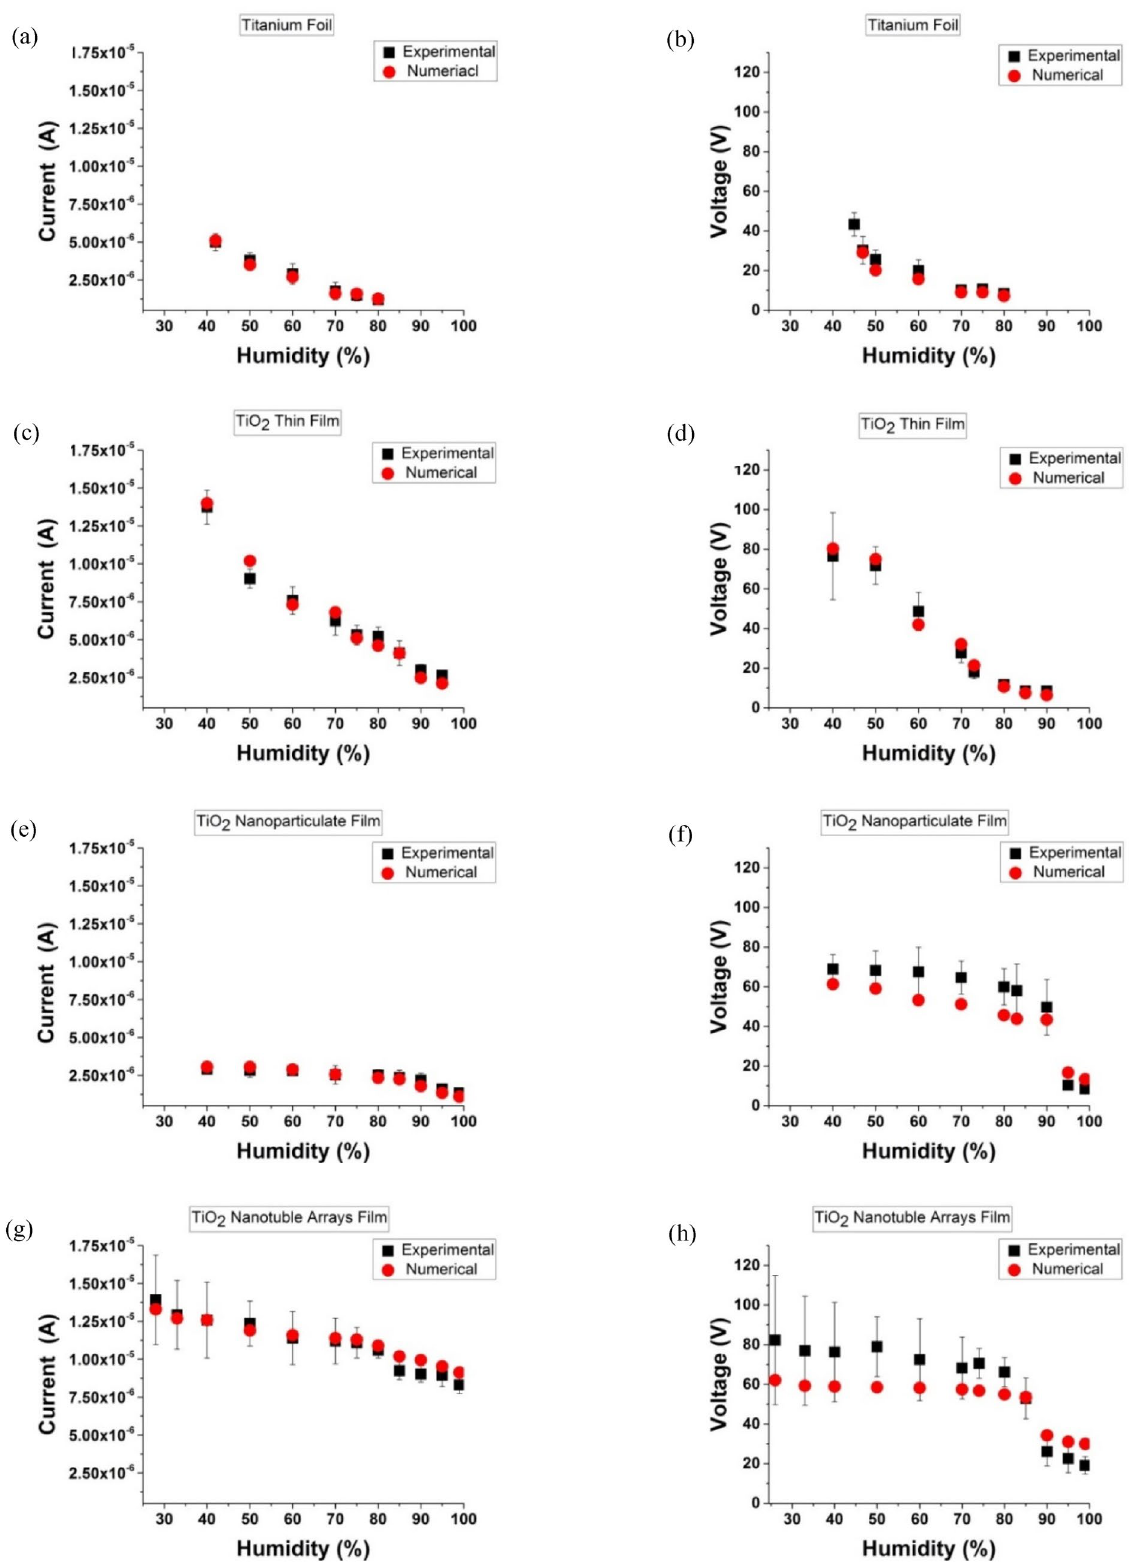
Figure 7. Comparison between the simulated electrical output and the experimental data in different morphologies of the triboelectric active layer: ( a,b ) Ti foil, ( c,d ) TiO 2 thin film, ( e,f ) TiO 2 nanoparticulate film, and ( g,h ) TiO 2 nanotube